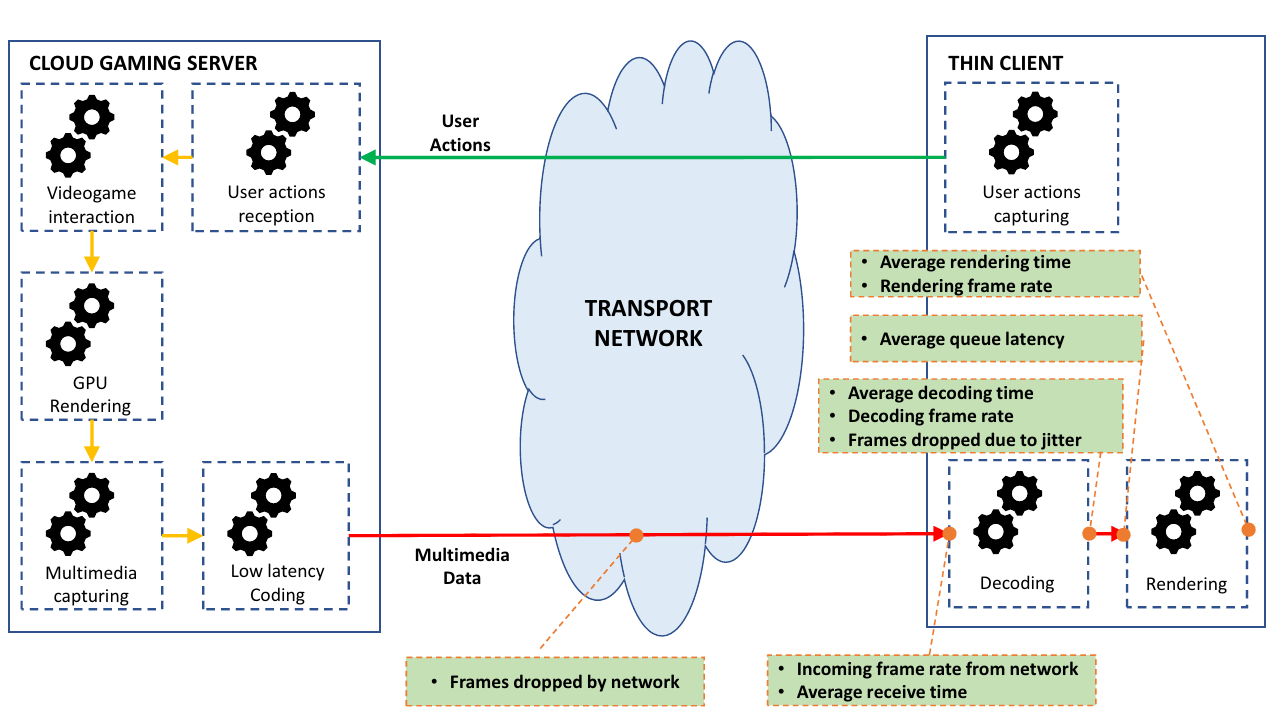
Figure 4. Metrics location in the Cloud Gaming